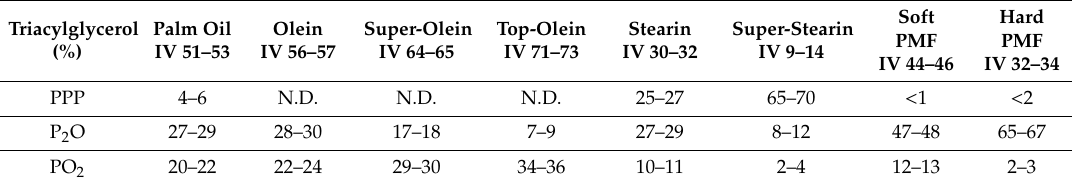
Figure 1. Multi-step dry fractionation of palm oil (PMF: palm mid fraction). Table 1. PPP, P 2 O and PO 2 contents (% by HPLC) obtained in some fractions from multi-step dry fractionation of palm oil. N.D.: not detectable; IV: iodine